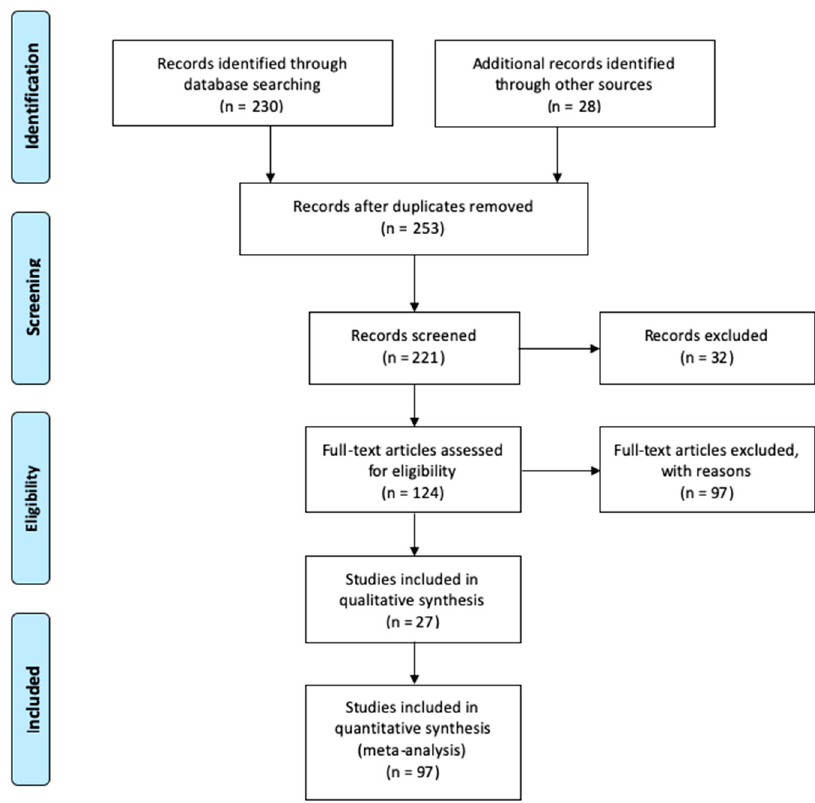
Figure 1. PRISMA flowchart, adapted [27].